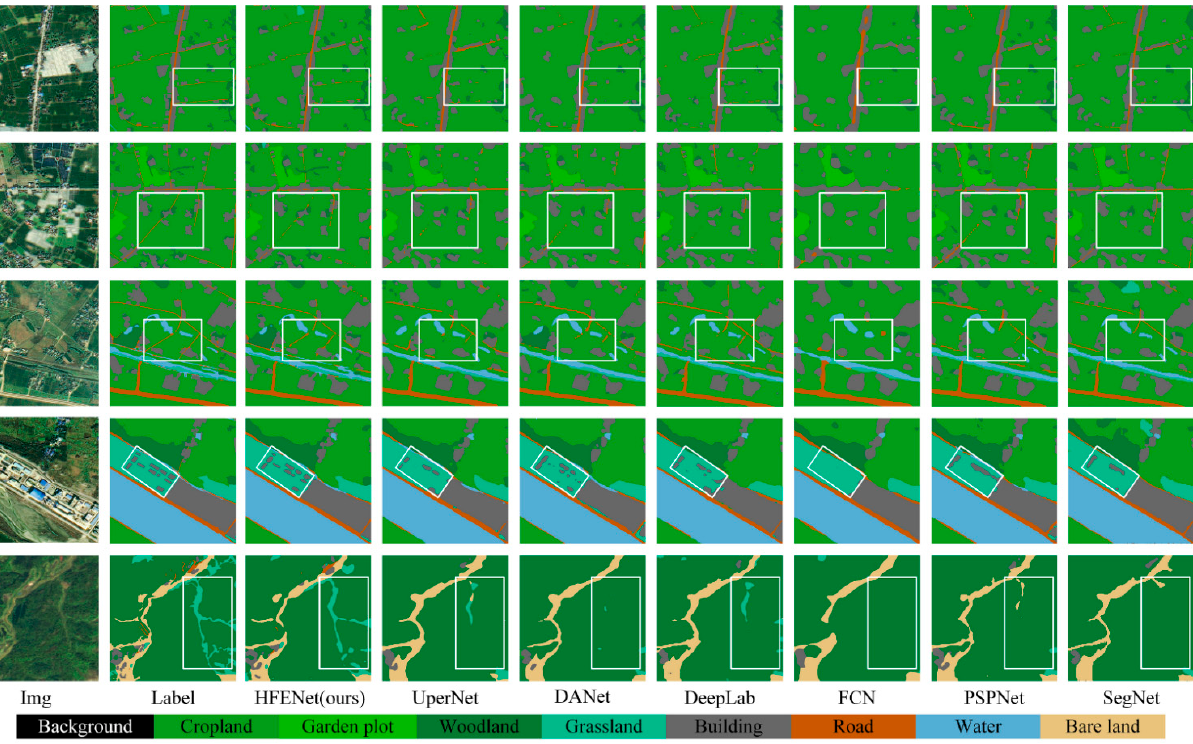
Table 6. Quantitative results of the state-of-the-art models on the WHU building dataset (%).